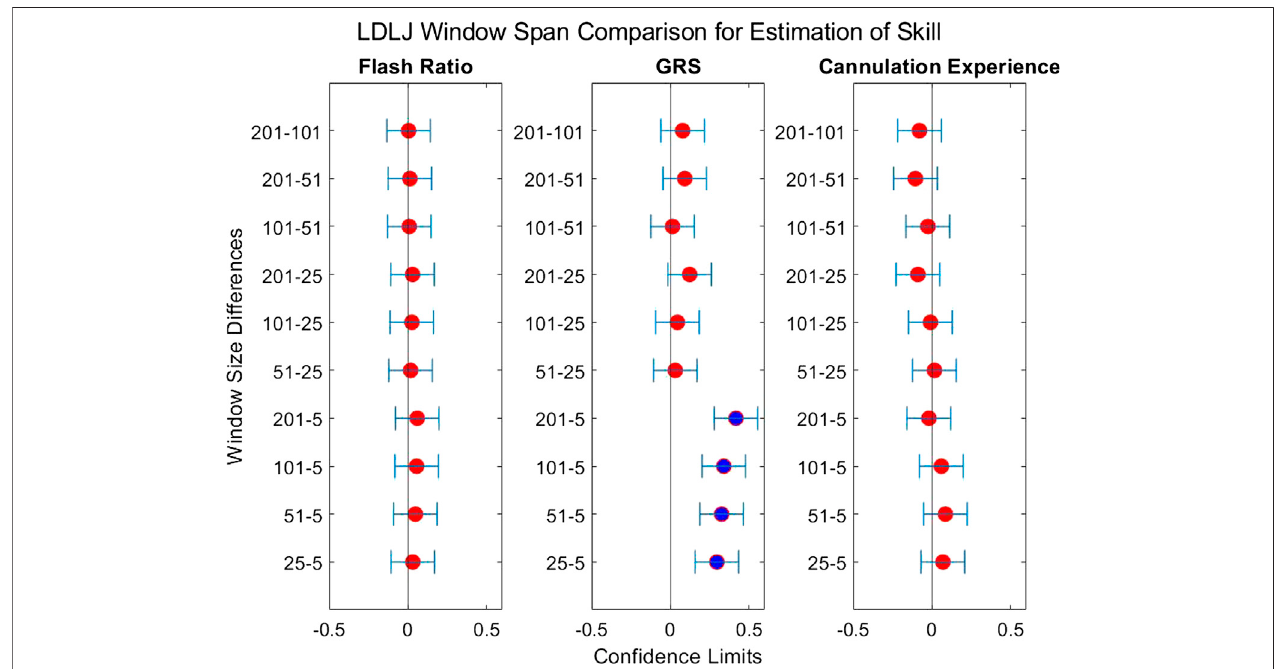
FIGURE 9 | Con fi dence intervals of each skill indicator metric ’ s association with LDLJ between the tested window spans. Ifthe con fi dence limits are both positive, the minuend is more associated with the corresponding skill indicator metric, and vice versa if the con fi dence limits are both negative. If the con fi dence interval passes through zero, there is no signi fi cant difference in the